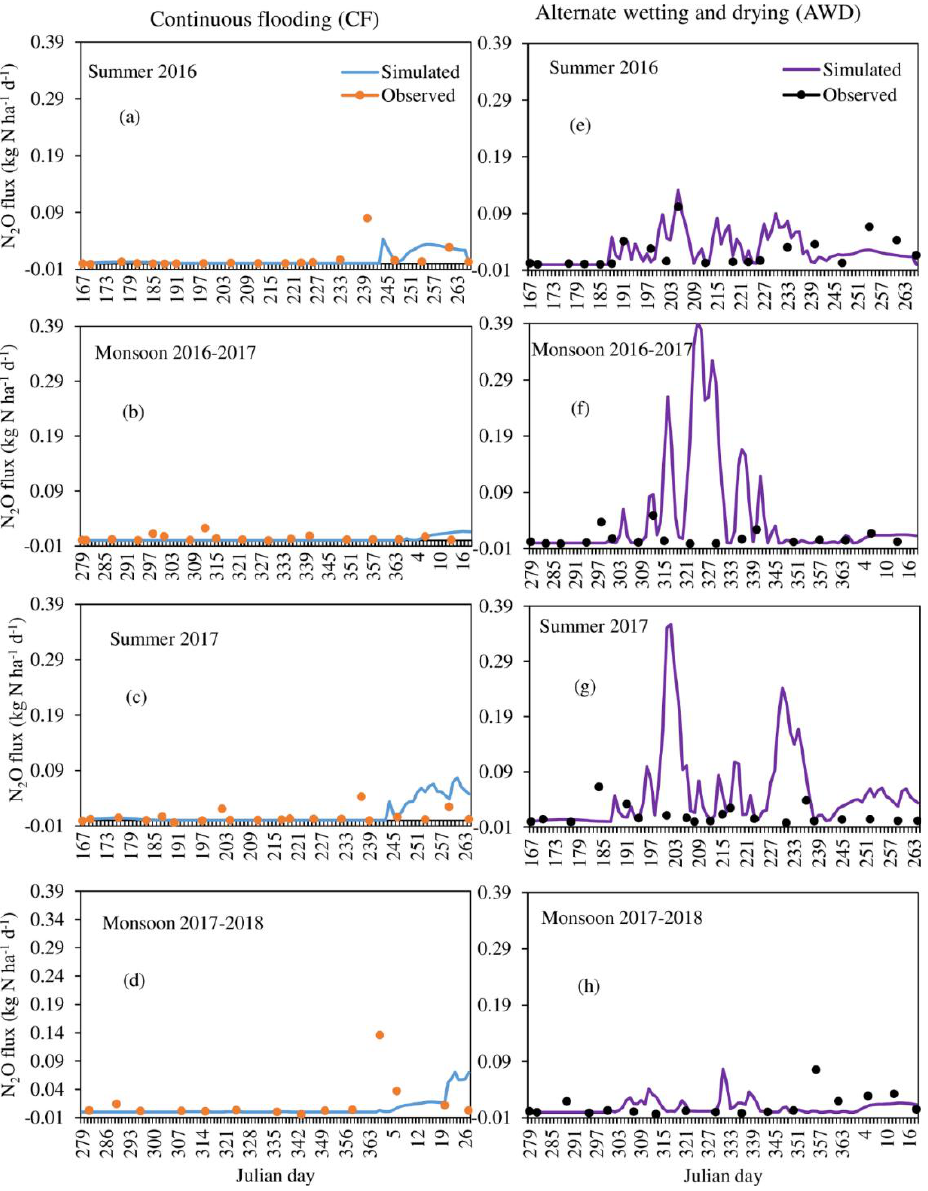
Figure 4. Observed and simulated N 2 O emissions from rice fields under continuous flooding ( a – d ) and alternate wetting and drying conditions ( e – h ) during different rice-growing seasons.